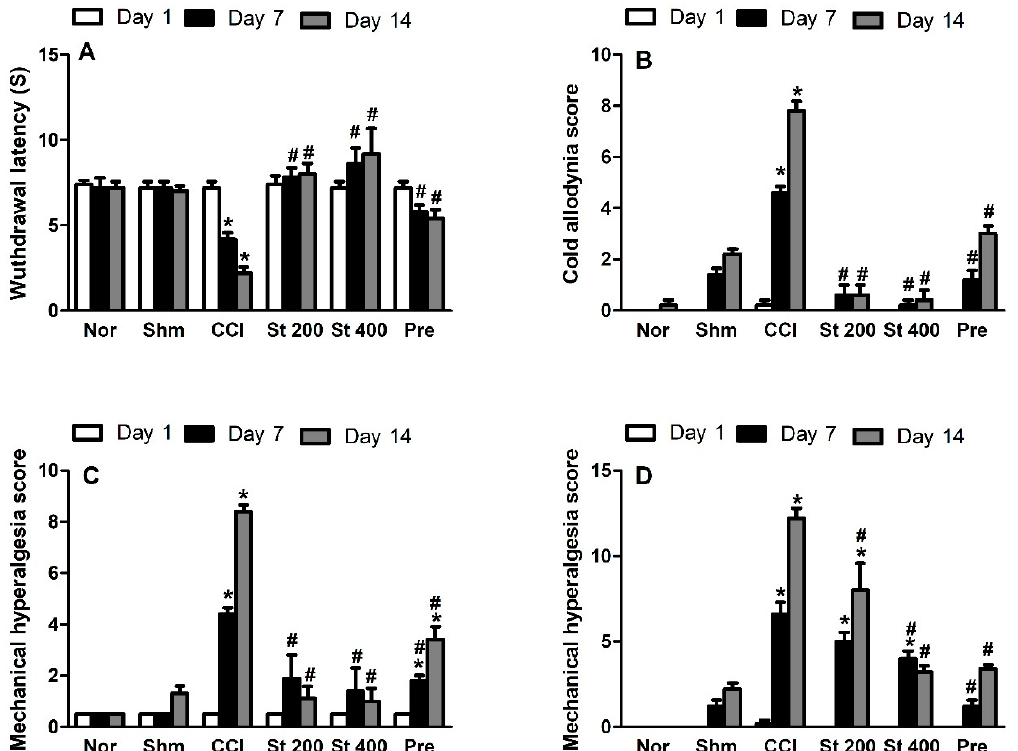
Figure 2. E ff ect of S. tetrasperma extract (200 and 400 mg / kg, p.o.) on ( A ) heat hyperalgesia (withdrawal latency) or ( B ) cold allodynia responses in rats with neuropathic pain induced by spinal nerve ligation ( C ) E ff ect of S. tetrasperma extract (200 and 400 mg / kg, p.o.) on mechanical hyperalgesia score as assessed by pin brick test in neuropathic pain rats induced by spinal nerve ligation. Paw withdrawal duration was recorded in seconds and ranges from 0.5 s for the brief normal response to 20 s (the cut-o ff time). ( D ) E ff ect of S. tetrasperma extract (200 and 400 mg / kg, p.o.) on mechanical dynamic allodynia as assessed by paint brush test in neuropathic pain rats induced by spinal nerve ligation. The number of withdrawals of total of 15 trials in response to a stimulus induced by paint brush was noted (between 0 and 15). Data is expressed as mean ± SE. * p < 0.05, compared to Sham group; # p < 0.05, compared to chronic constriction induced sciatic nerve injury (CCI) group at the corresponding time points. Norm means normal group; Shm means Sham group; St 200 and St 400 mean S. tetrasperma extract (200 and 400 mg / kg) and pre means pregabalin